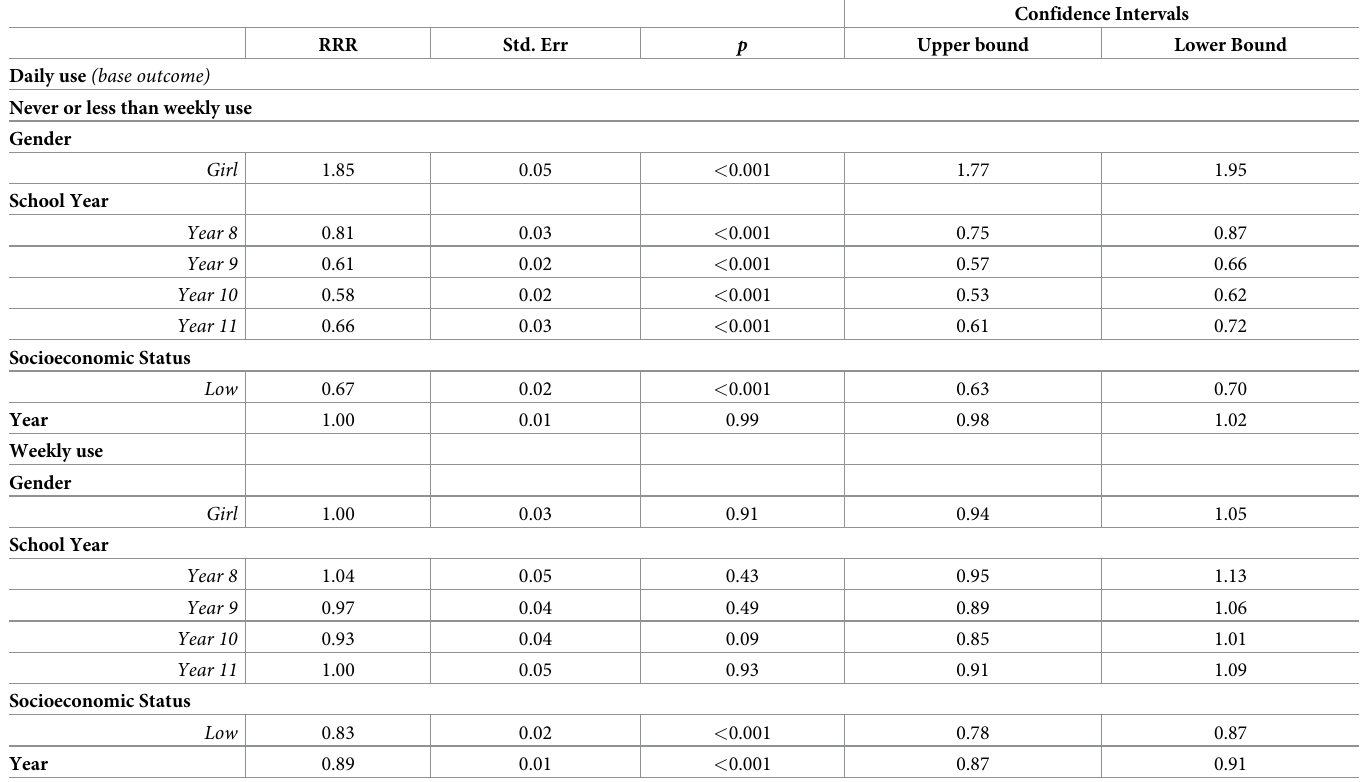
Table 3. Multinomial regression of ED consumption and sociodemographic characteristics with daily use as the reference category (n =